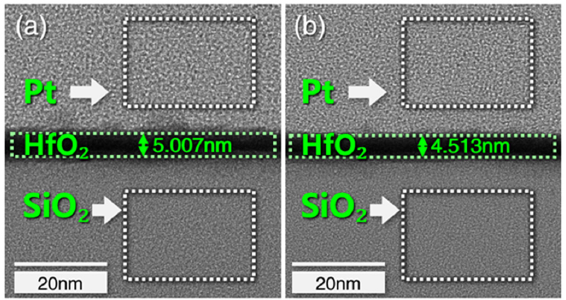
Figure 3. ( a ) Initial coating section; ( b ) after 15 pulses.